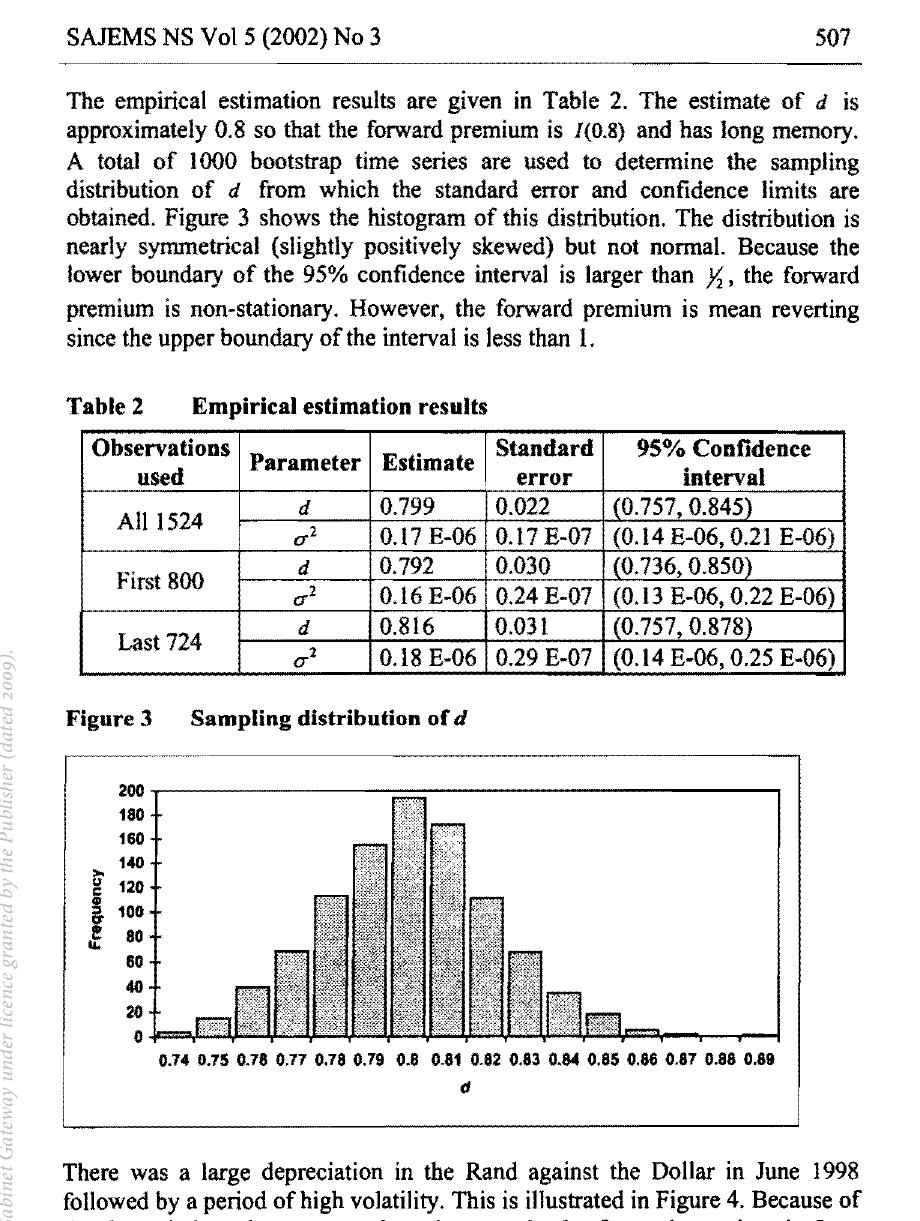
Sampling distribution of